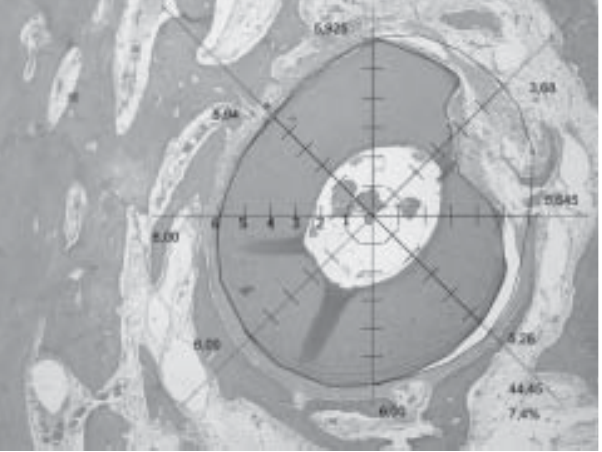
Fig. 1 - Method of measuring root structure loss with superimposed eight point grid on histologic section Hematoxiylin and eosin